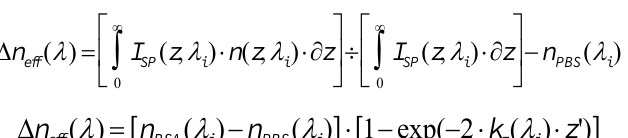
as a function of E-k SPR y | , in time for the SPR Total = 33 × 10 − 3 ± 1 × 10 − 3 µm − 1 is measured after s